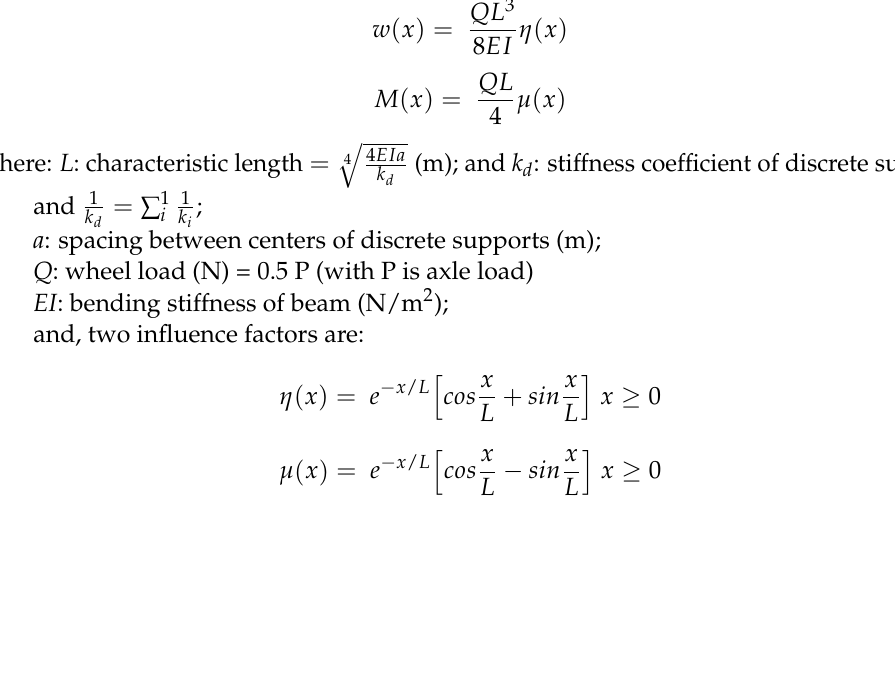
Figure 8. Beam on elastic foundation model.